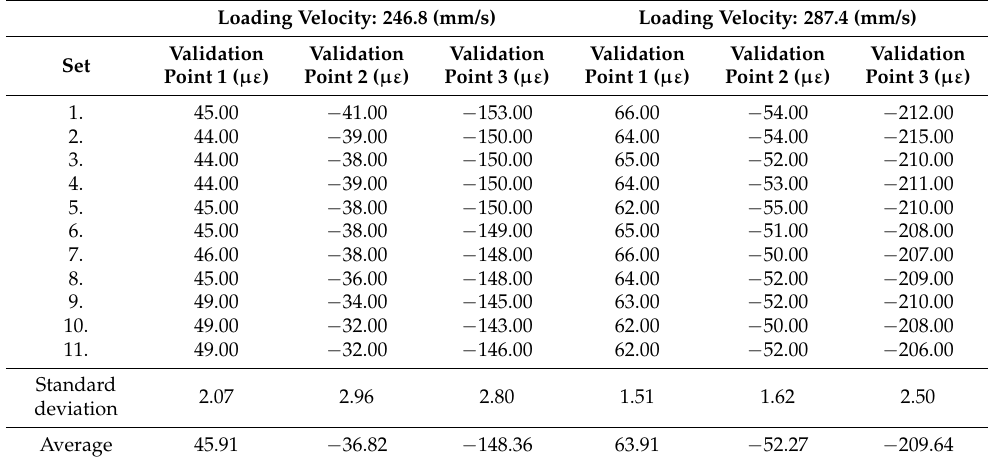
Table 4. Peak strain of validation points measured in 11 sets of experiments for two loading velocities.